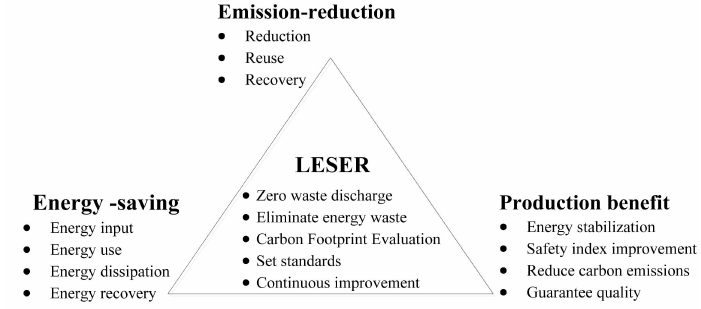
Figure 6. Promoting sustainability of manufacturing industry by LESER